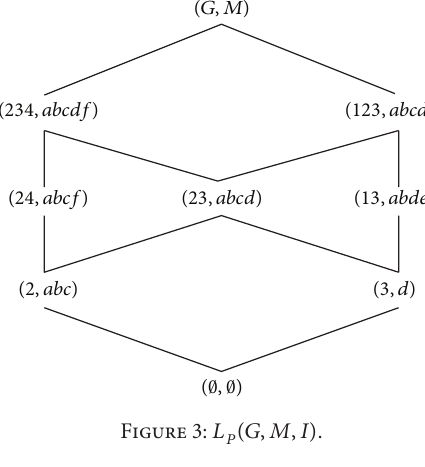
Figure 3: 𝐿 𝑃 (𝐺, 𝑀, 𝐼) .